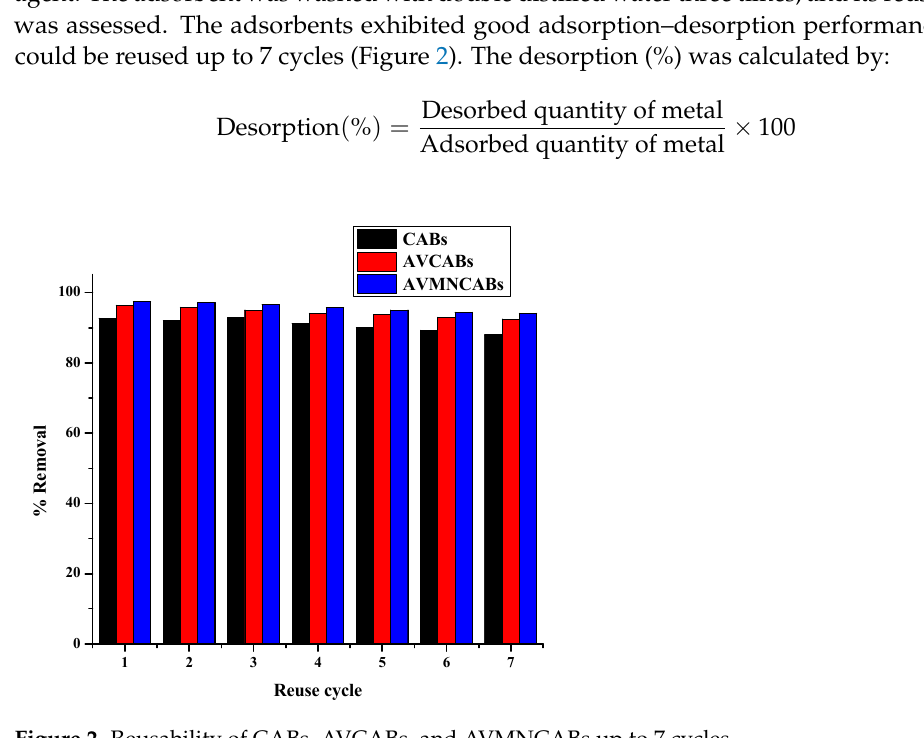
Figure 2. Reusability of CABs, AVCABs, and AVMNCABs up to 7 cycles. 92.7%, 96.4%, and 97.4% desorption were obtained for CABs, AVCABs, and AVMN- CABs,